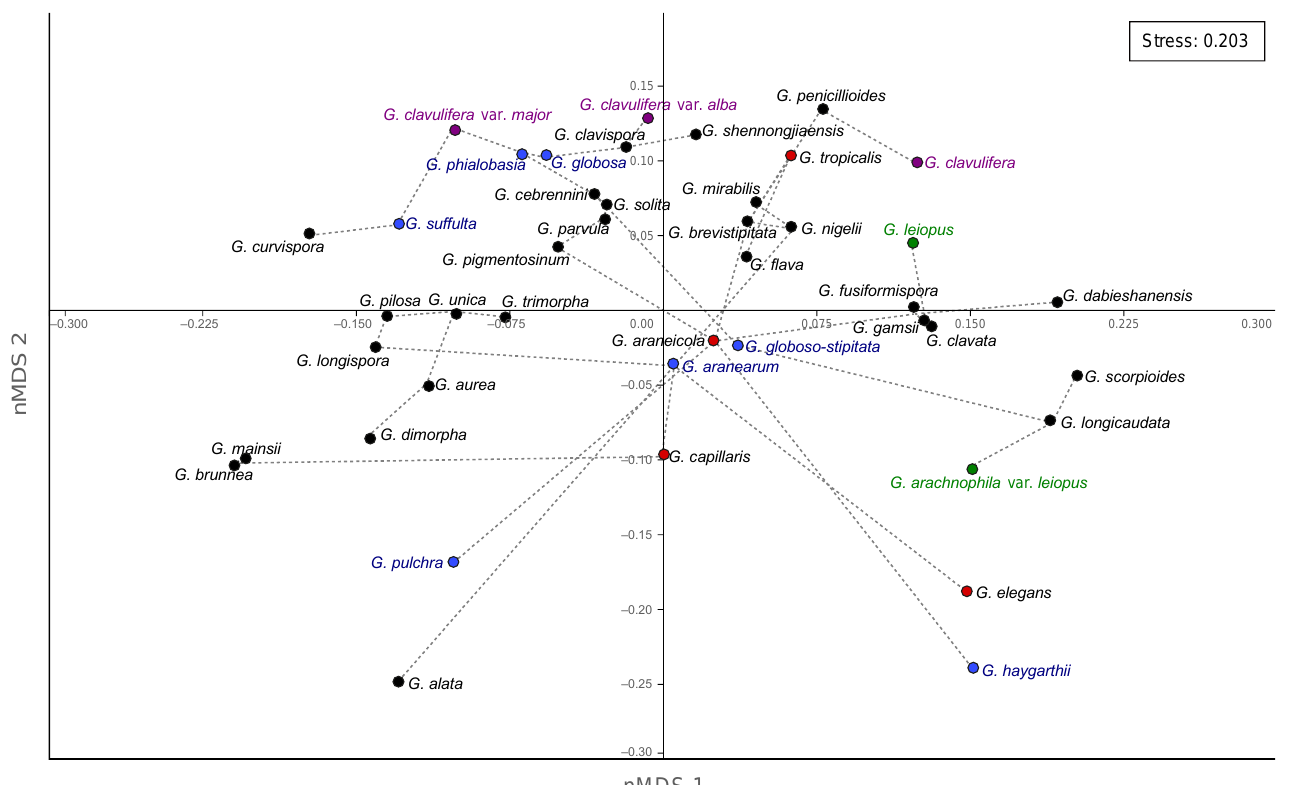
Figure 2. Non-Metric Dimensional Scaling (nMDS) performed using the morphological data of species descriptions for the genus Gibellula . Species that remain with the same name of original descriptions (accepted) are in black while species that were considered invalid are in red. The forms described for G. clavulifera are highlighted in purple, showing their intraspecific variation. The descriptions that were synonymised as G. leiopus are shown in green and those synonymised as G. pulchra are shown in blue, indicating a high variation among morphological characters. Grey lines show the Minimum Spanning Tree.